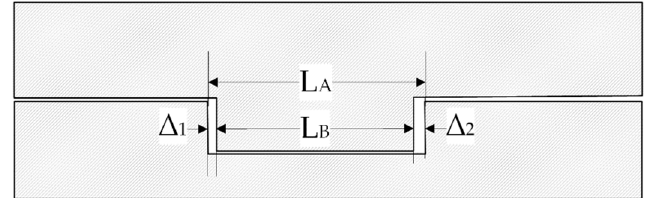
Figure 1. Coordination accuracy of a keyway assembly.